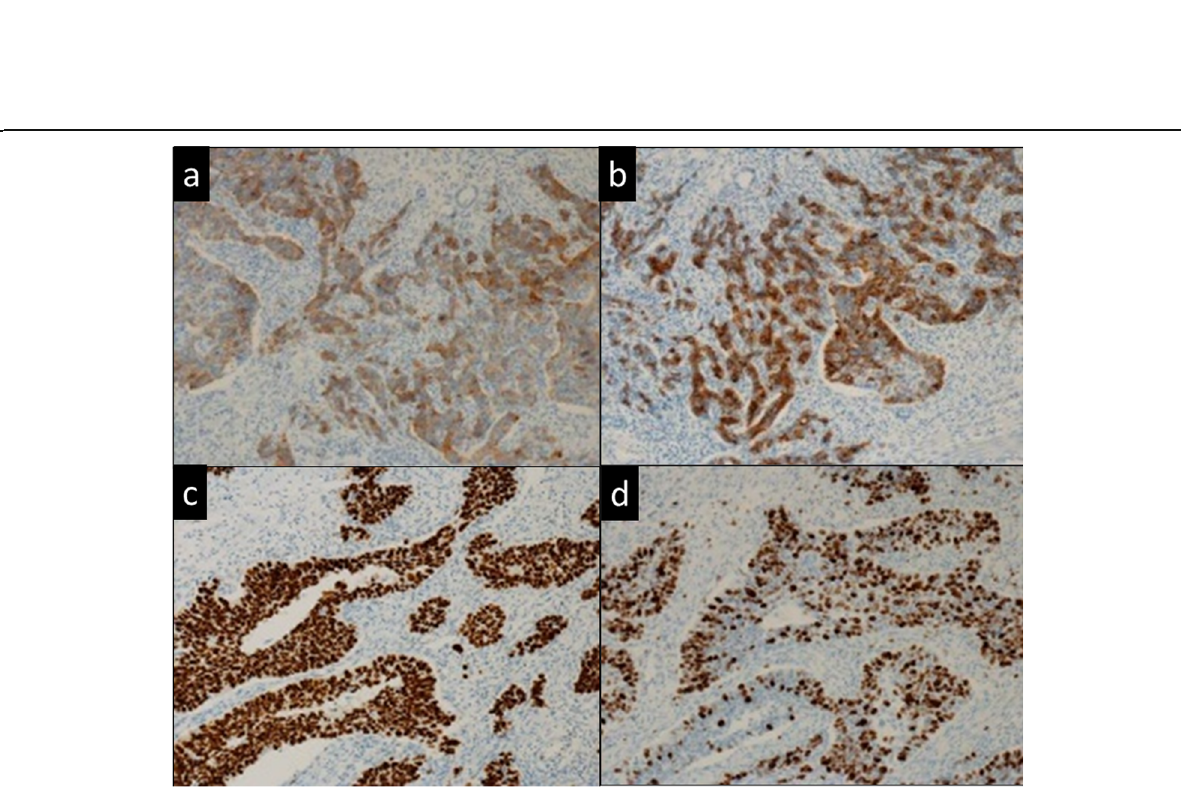
Fig. 6 Immunohistochemical findings. a Synaptophysin stain. b Chromogranin stain. c Ki-67 stain. d p53